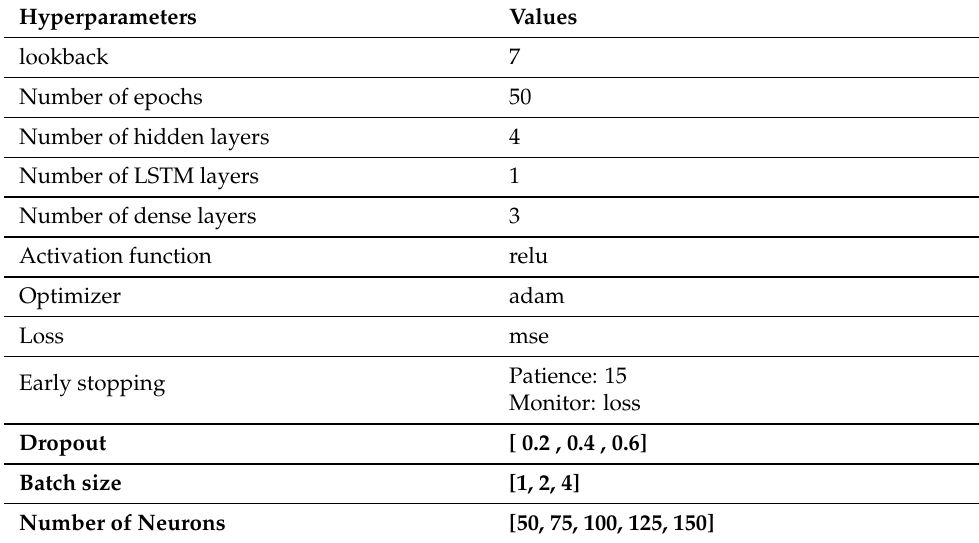
Table 12. Hyperparameters used in the LSTM ensemble